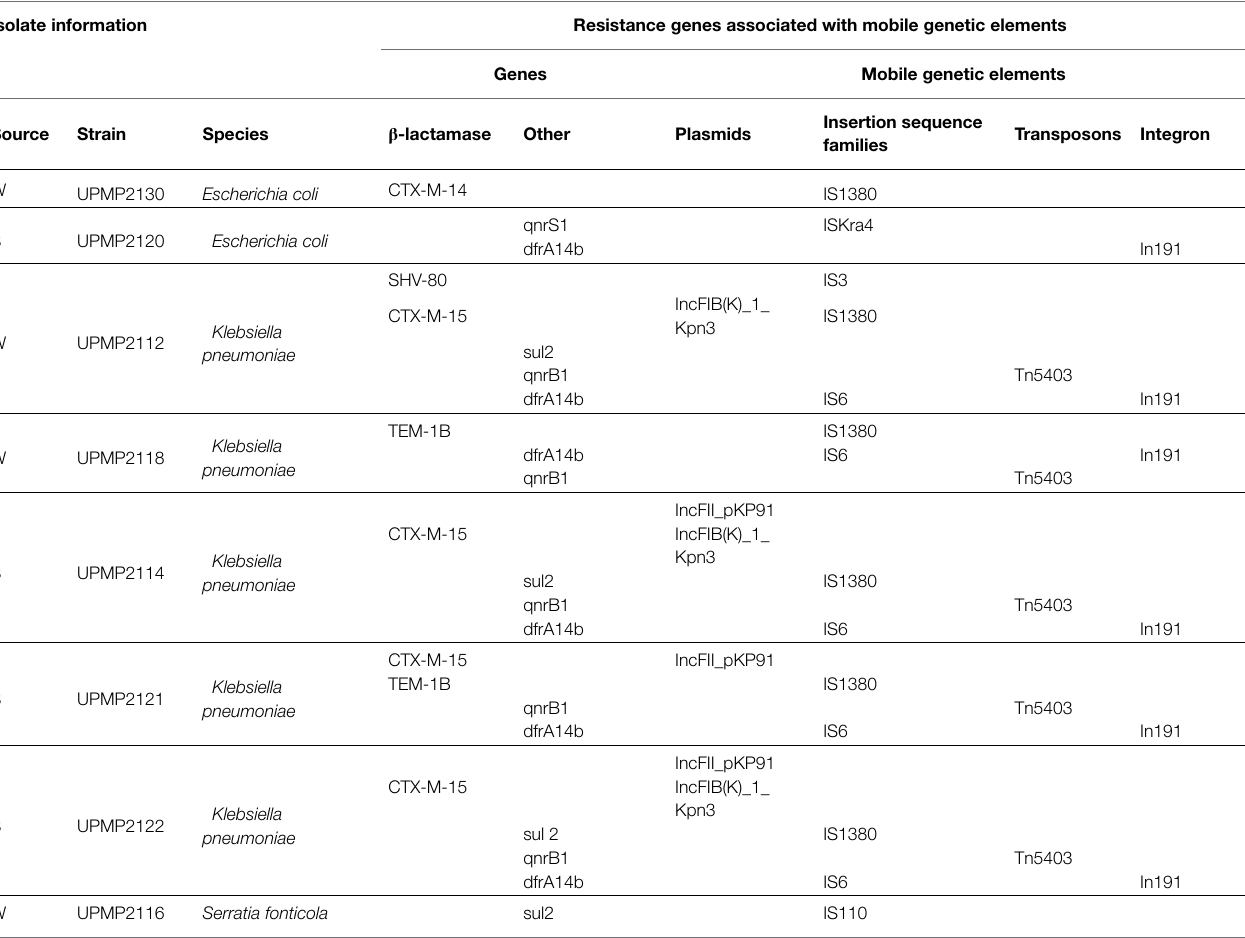
TABLE 3 | Extended-spectrum β -lactamase (ESBL)/AmpC β -lactamase (AmpC)-producing Enterobacterales with resistance genes related to mobile genetic